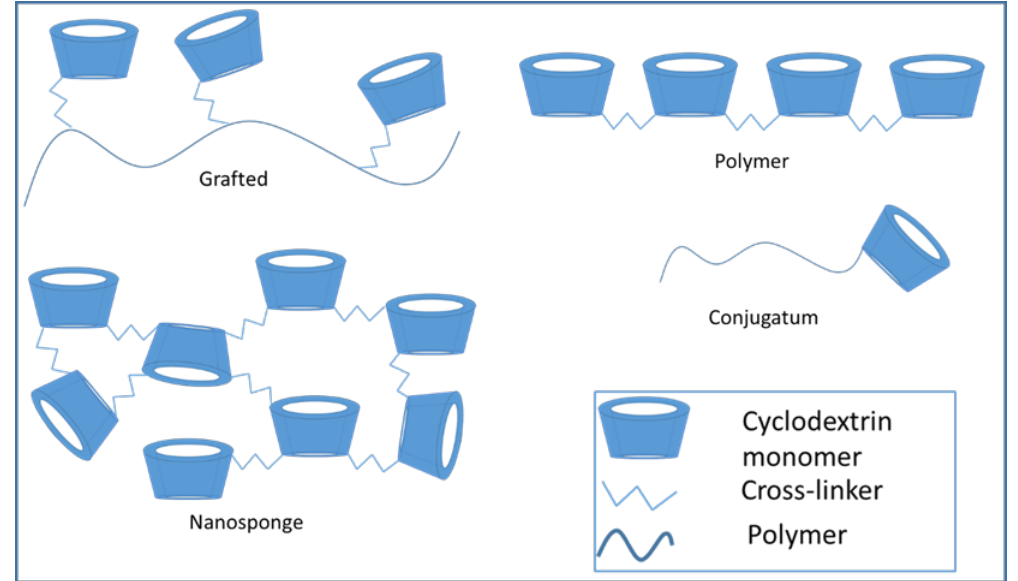
Figure 3. Cyclodextrin conjugates, polymers, and nanosponges .